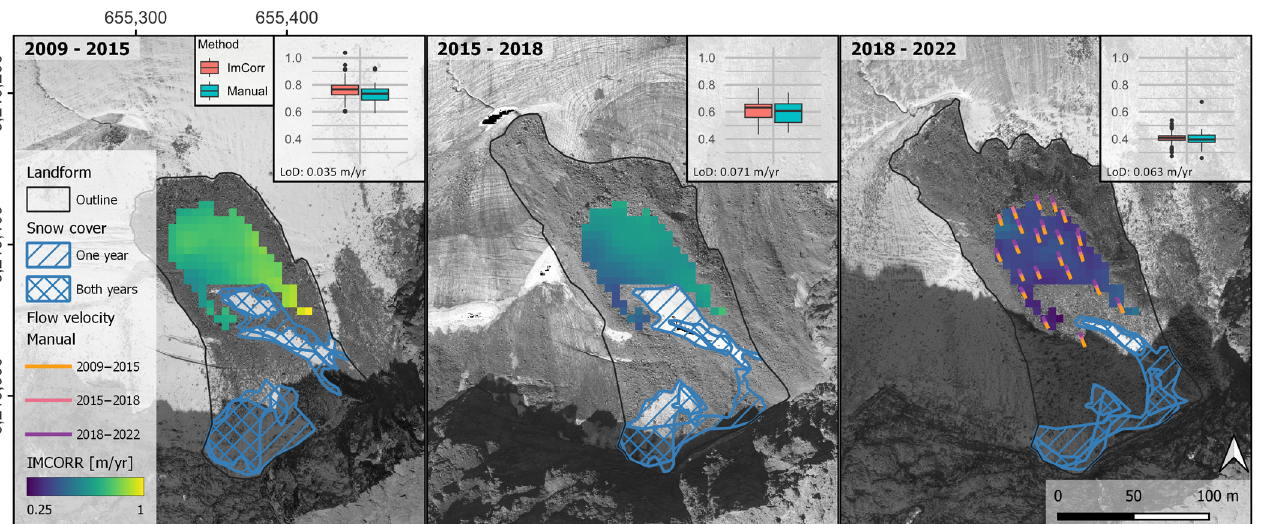
Figure 4. Development of ice thickness of the Zwieselbachferner. The initial ice thickness (2006) is modeled by Helfricht et al. [65], and the further development of ice thickness is derived by subtracting the respective DoDs from this data (for a more detailed description of the approach see Sections 2.6 and 4.1).